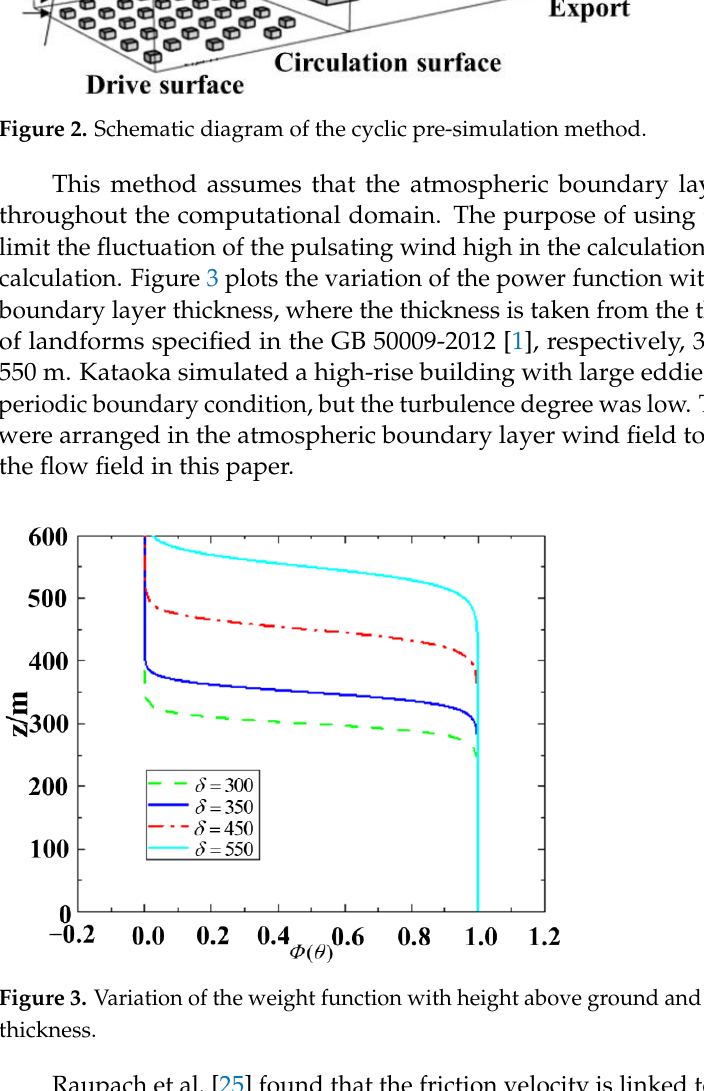
Figure 2. Schematic diagram of the cyclic pre-simulation method.